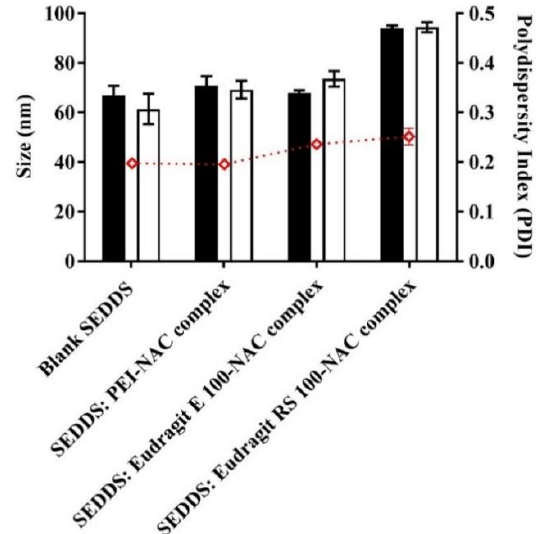
Figure 4. Average droplet size at 0 h (black bars) and 4 h (white bars) and the polydispersity index ( ) of different SEDDS droplet types classified as a blank SEDDS, and SEDDSs loading three different NAC ionic complexes with PEI, Eudragit E, and Eudragit RS, following 1:100 dilution in release medium at 37 °C. The values given are the means ± standard deviations ( n ≥ 3).